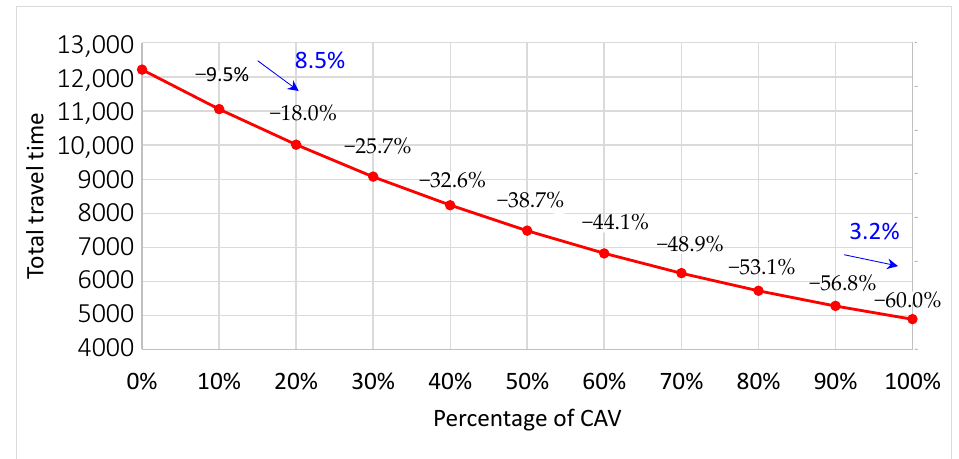
Figure 5. Total travel time improvement as the percentage of CAVs.